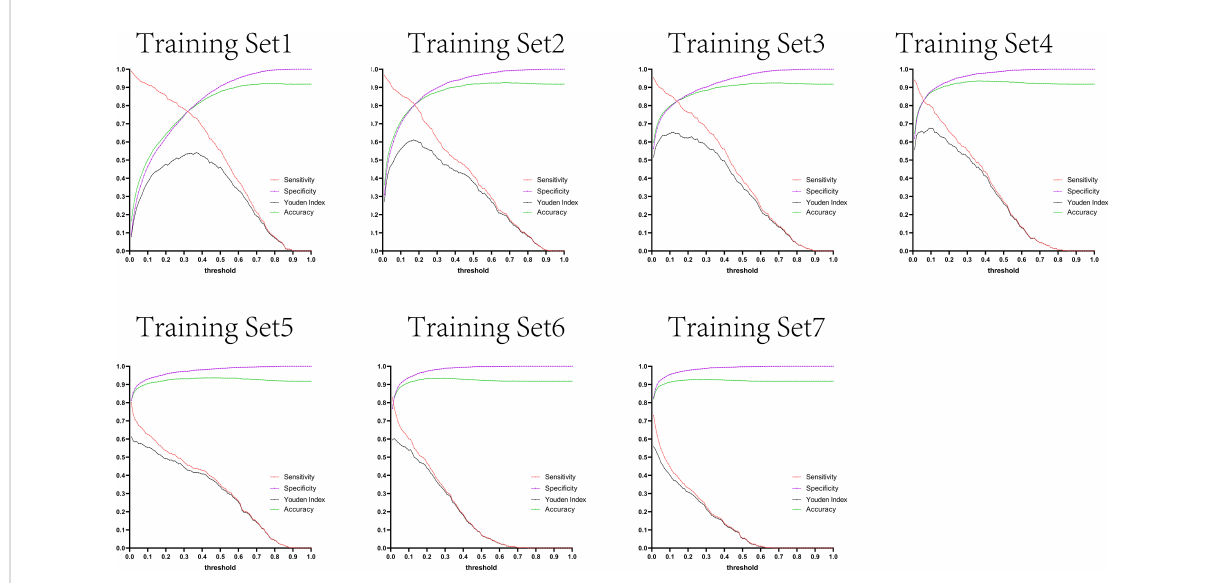
FIGURE 10 Curves of sensitivity, speci fi city, Youden index, and accuracy with threshold after test set 1 was tested separately by seven training set